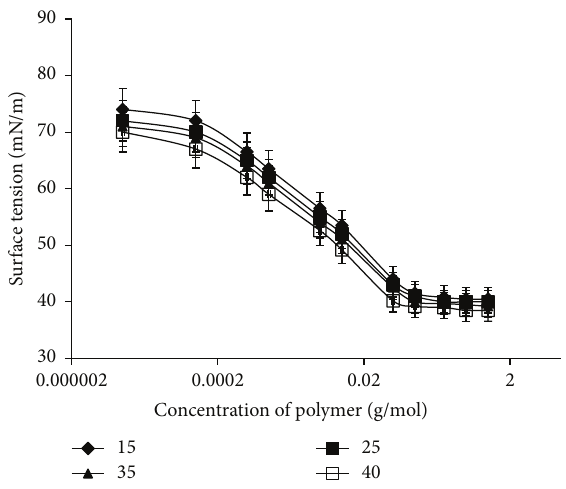
Figure 3: Surface tension of PS62 as a function of its concentration, determined at various temperatures.